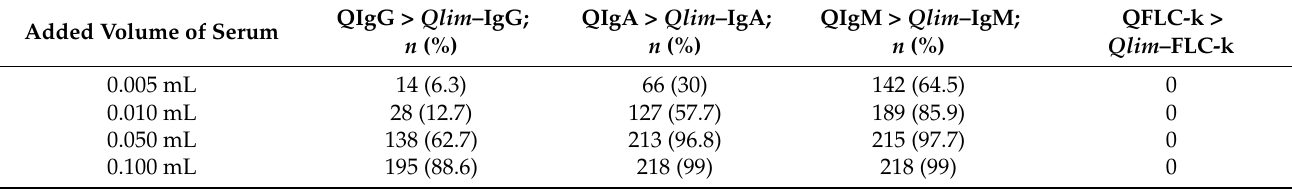
Table 2. Number of patient data developing a QIgG/IgA/IgM/FLC-k > Qlim –IgG/IgA/IgM/FLC-k in the quotient diagram after simulating blood contamination of 2 mL cerebrospinal fluid (CSF) with the given volume of serum.